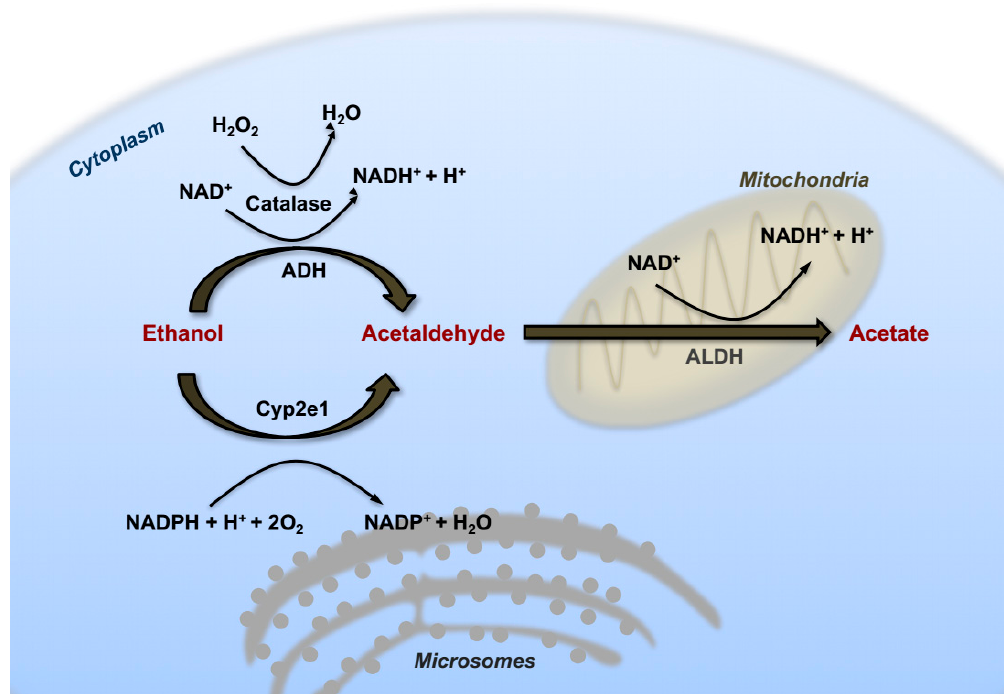
Figure 1. Hepatic alcohol metabolism. Schematic representation of the most important cellular pathways involved in ethanol metabolism localized in the different cellular districts. Alcohol is at first oxidized to acetaldehyde by alcohol dehydrogenase (ADH) in the cytosol or through the activation of the inducible microsomal enzyme CYP2E1. The heme-containing enzyme catalase can also participate to ethanol oxidation in the peroxisomes. Thereafter acetaldehyde is converted to acetate by the acetaldehyde dehydrogenase (ALDH) located in the mitochondria. Acetate can freely diffuse into the circulation.